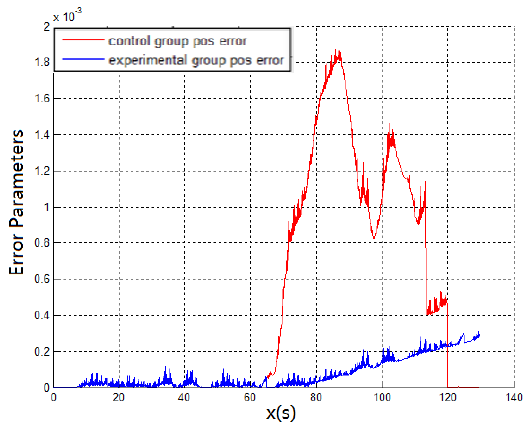
Figure 8. Experiment 1 and Experiment 2 position error.